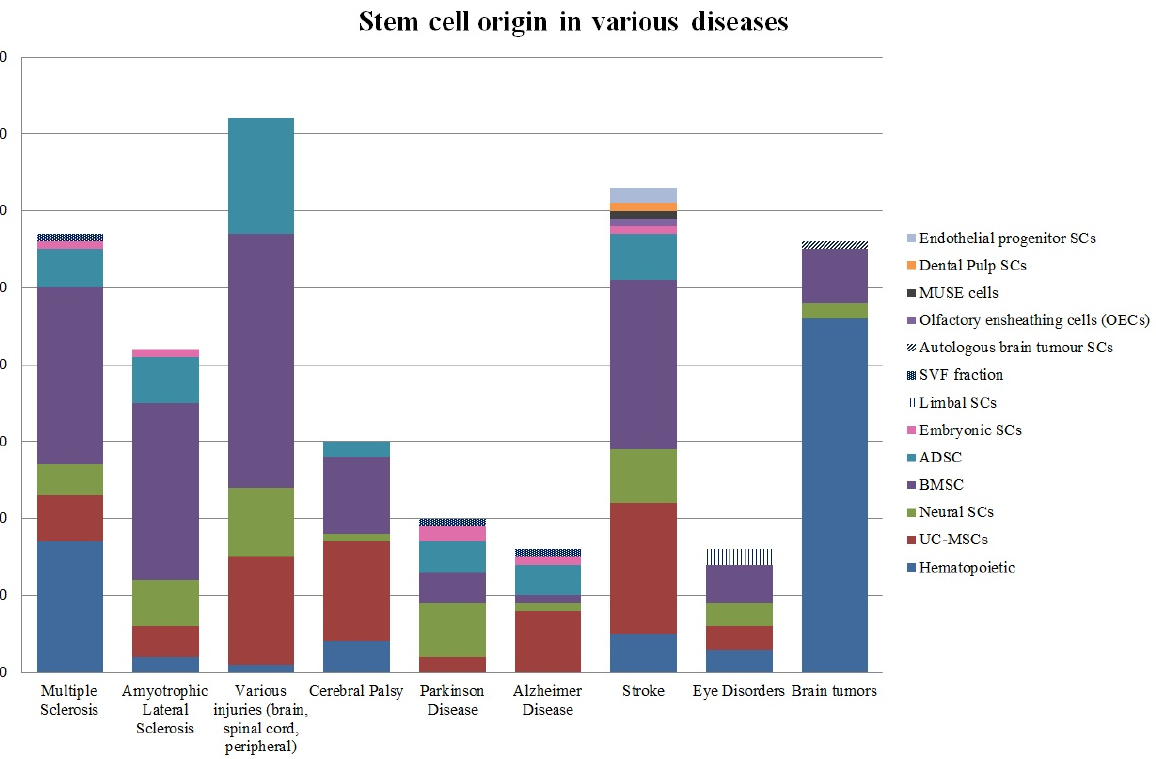
Figure 5. Types of stem cells in different conditions. Olfactory ensheathing cells (OEC’s) (NCT01327768), MUSE cells (NCT04261335), endothelial progenitors (NCT01468064 and NCT02605707), dental pulp SC’s (NCT04608838) were only encountered in “stroke” group making it the most diverse group among others. Limbal SC’s were only found in “eye disorders” group. SVF fraction was present in “Parkinson’s” (NCT03297177), “Alzheimer’s” (NCT03297177), and “multiple sclerosis”